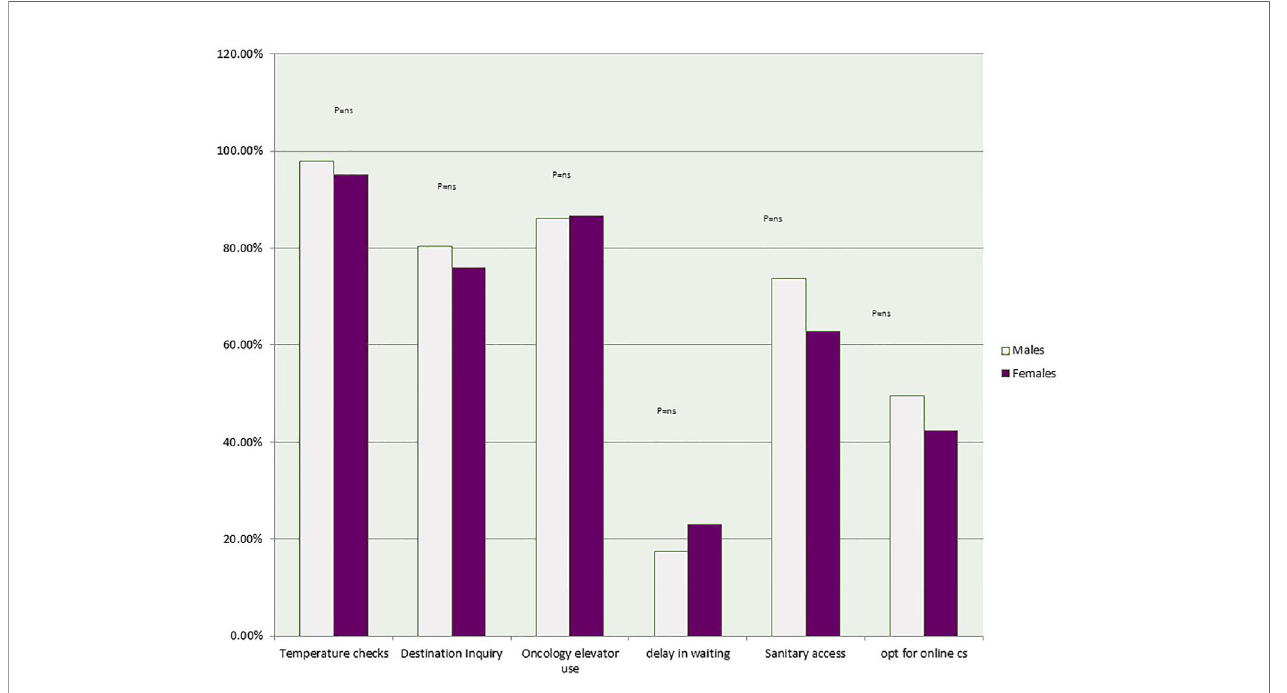
FIGURE 4 | Demonstration of precautionary strategies implemented by NKBCI as per sex